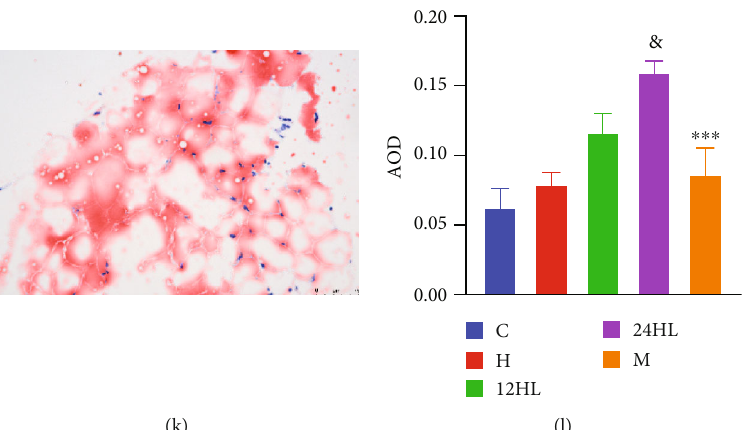
Figure 6: E ff ects of melatonin on histopathological changes in adipose tissue. H&E staining (200x): (a) C group, (b) H group, (c) 12HL group, (d) 24HL group, and (e) M group after treatment (on week 10); (f) AOD of H&E staining. Oil Red O staining (200x): (g) C group, (h) H group, (i) 12 HL group, (j) 24HL group, and (k) M group after treatment (on week 10); (l) AOD of Oil Red O staining. Integrated optical density (IOD)/area of staining in each immunohistochemistry staining image. AOD: average optical density; C: control group; H: HFD group; 12HL: 12h light group; 24HL: 24h light group; M: melatonin group. The values are expressed as the means ± S : D : ( n = 3 per group). & P < 0 : 05 , 24HL vs. 12HL group; ∗∗ P < 0 : 01 and ∗∗∗ P < 0 : 001 , M vs. 24HL